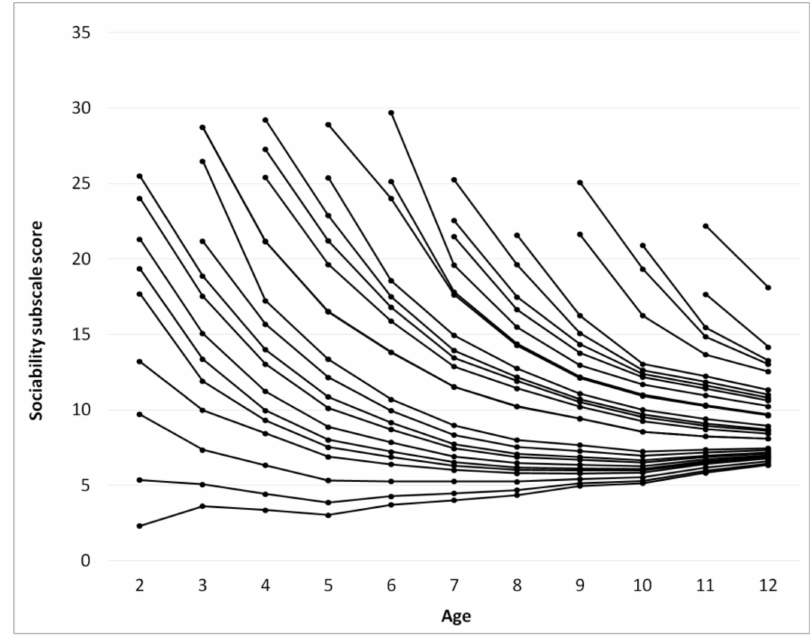
Figure 4. Continuous changes of the Sociability subscale score over age calculated from pair-wise observations using the “relay” procedure.